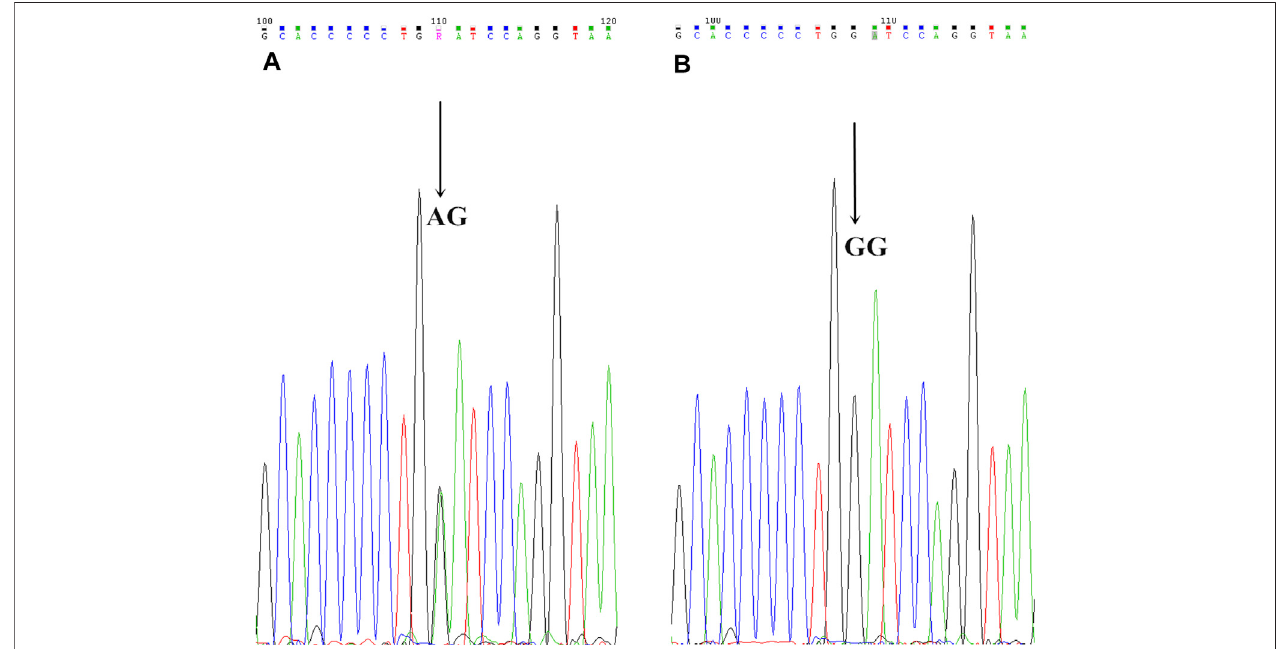
FIGURE 4 | CYP2C19*3 mutant allelic variant map. AB is the mutation sequence, the arrow is the mutation site (AA/GG), where AG is the mutant gene.